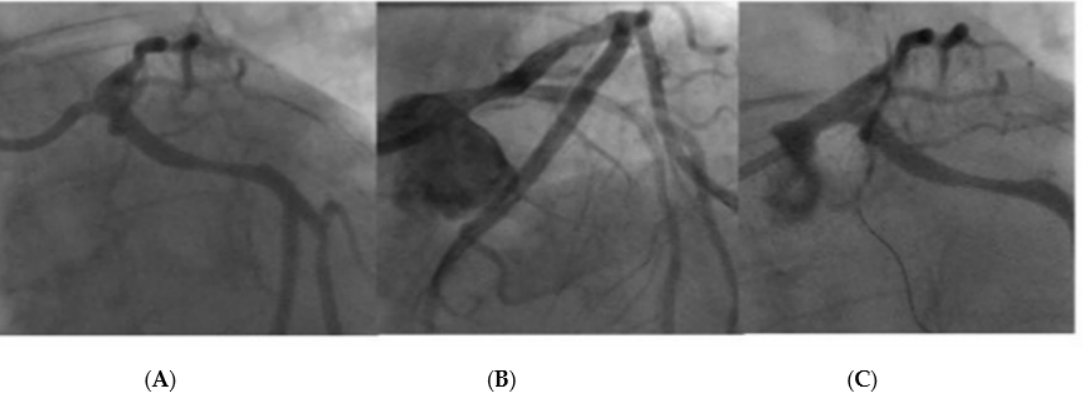
Figure 11. LMS lesion requiring bail-out stenting after DCB. This patient had an appearance of a type B dissection however there was persistent contrast hang-up in the dissection, resulting in bailout stenting. Image ( A ): Lesion pre-treatment, Image ( B ): Type B linear dissection after DCB, Image ( C ): Lesion after final DES treatment.